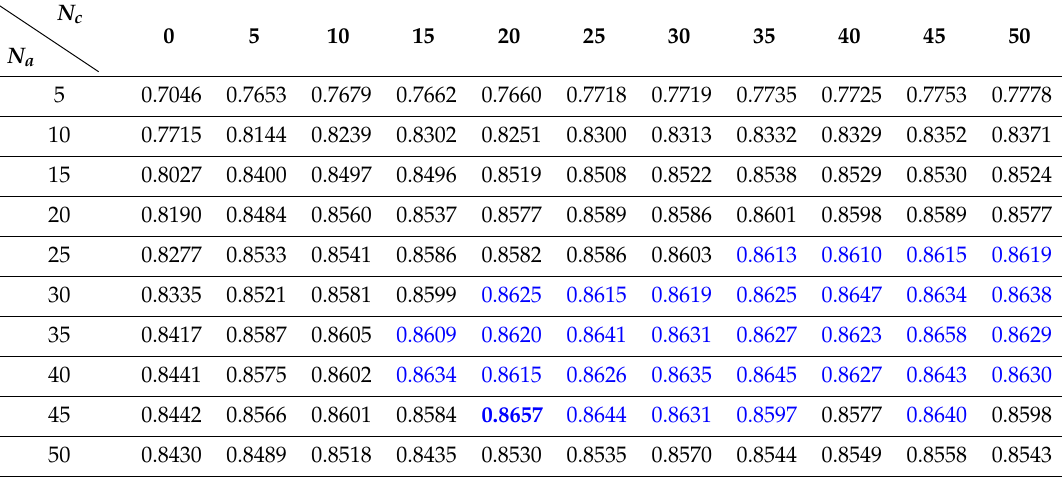
Table 2. Average F-Measure scores obtained on camera jitter category using di ff erent N a and N c . N c N a